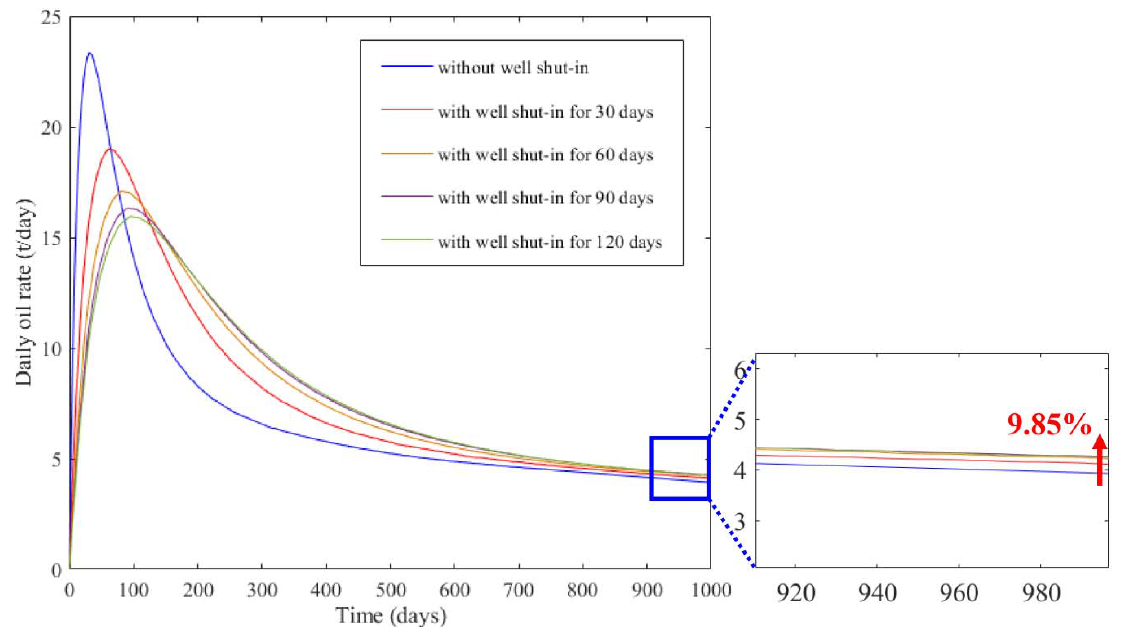
Figure 9. Oil production rate for the first 1000 days after different shut ‐ in times.